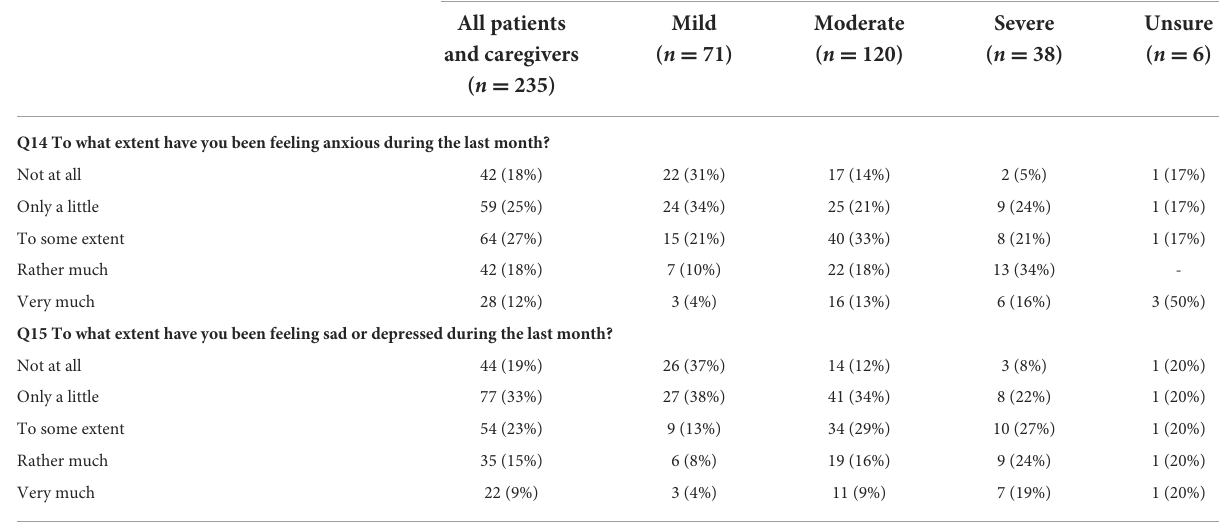
TABLE 5 Impact of FAs on anxiety and depression in each severity